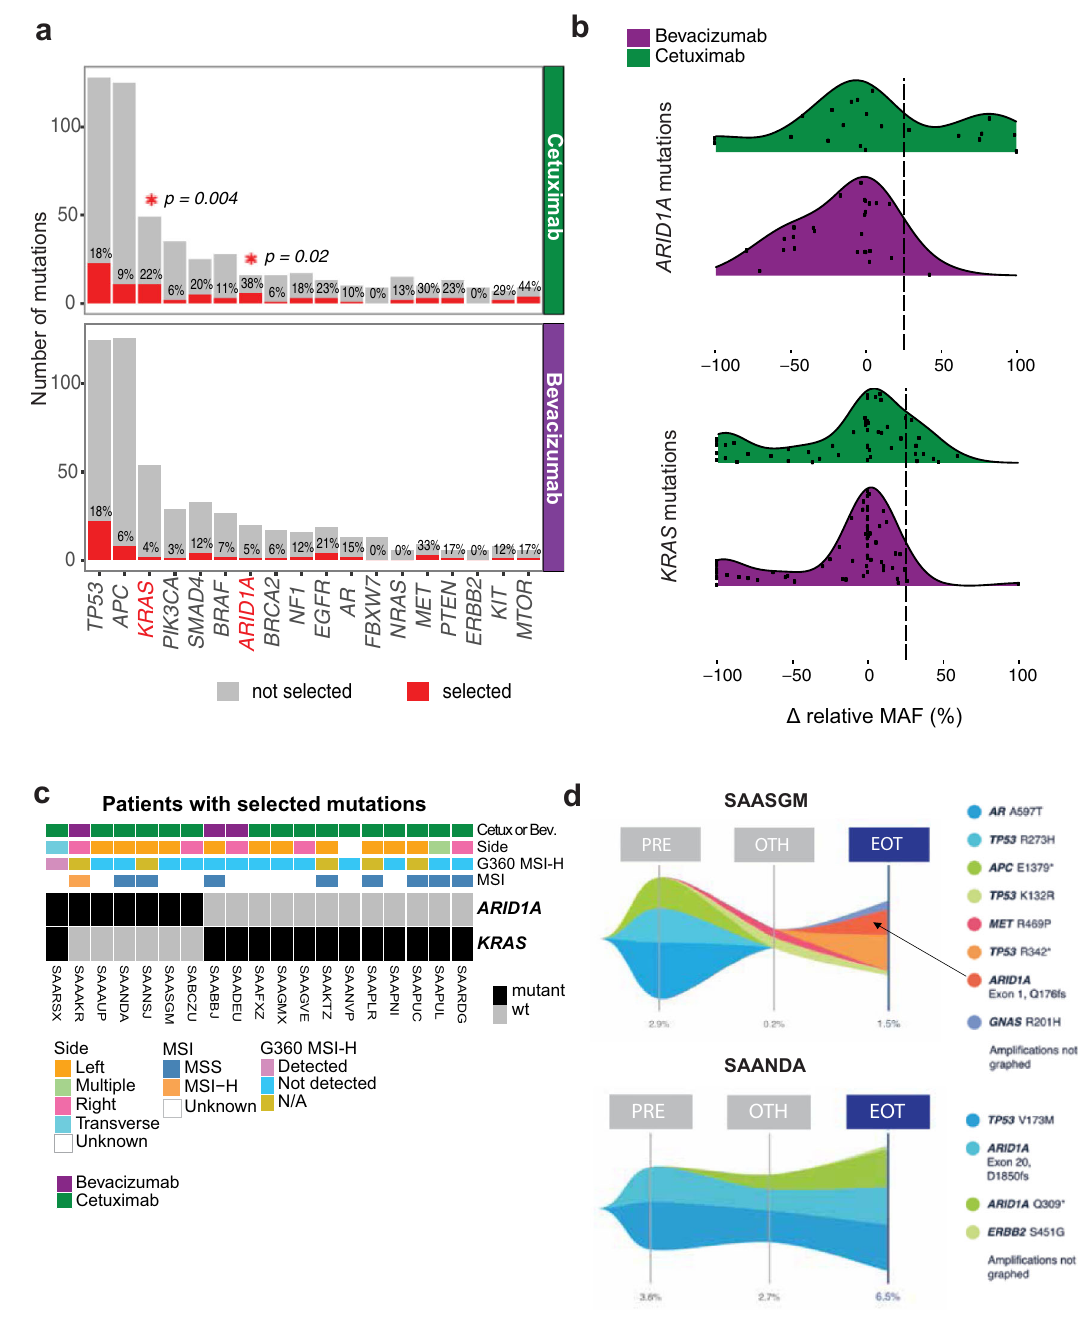
Fig. 1 | ARID1A and KRAS mutations are enriched in patients treated with cetuximab. a Numberof patients with genomic alterations at either timepoint per treatment arm. Genomic alterations include non-synonymous single-nucleotide variants (SNV), indels, and gene rearrangements. Layered above the red bar is the corresponding percentage of patients with selected alterations, de fi ned as an increase by 25 percentage points in the normalized MAF, calculated relative the highestreportedMAF,betweenpairedbaselineandendofstudycfDNAfrom3331L mCRC patientstreated with eitherbevacizumabor cetuximab in combination with chemotherapy in the CALGB/SWOG 80405 trial. Asterisks indicate statistically